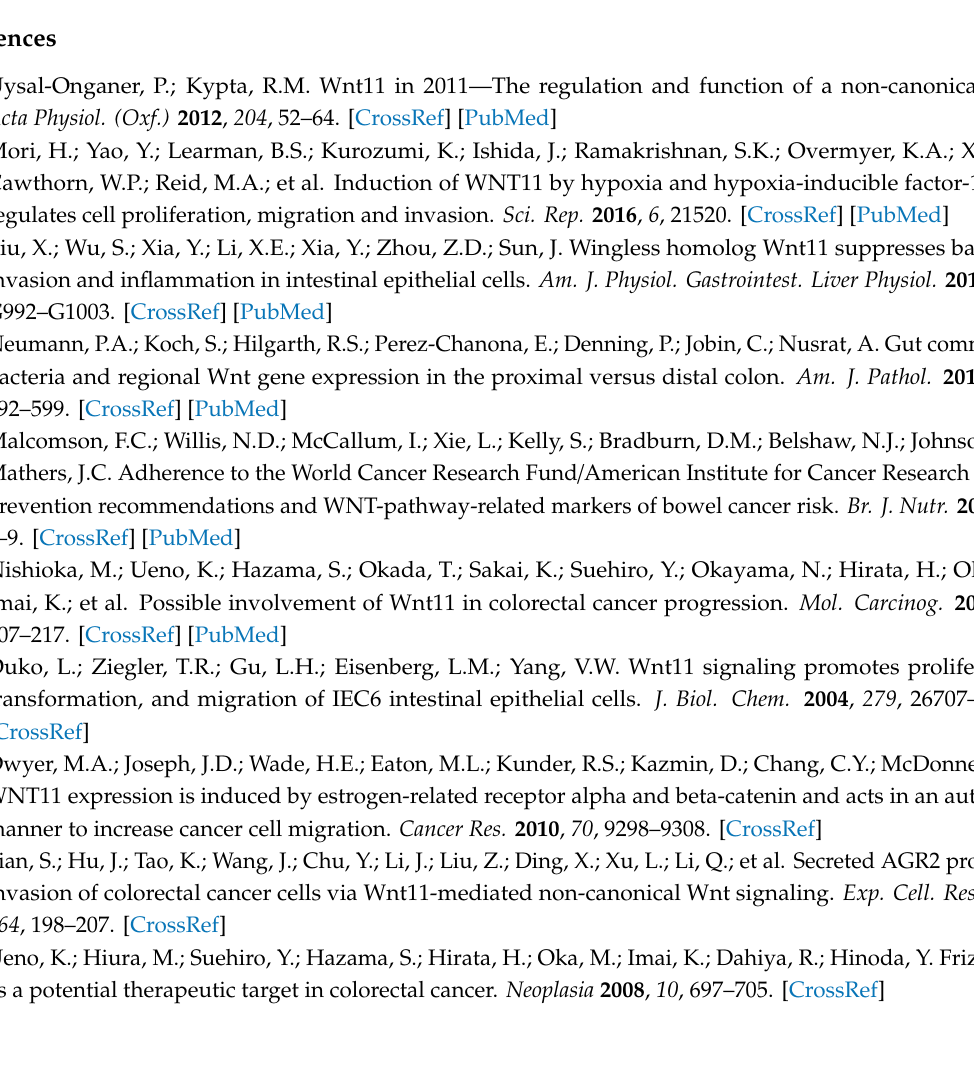
Wnt receptor expression in colorectal cancer, Table S2: Comparison of patients with tumors having very high Wnt-11 versus moderate, low or no Wnt-11 (Figure 2a), Table S3: Comparison of patients with tumors having high or very high Wnt-11 versus moderate, low or no Wnt-11, Table S4: Unadjusted analysis for 3-year mortality, Table S5: Unadjusted analysis for 5-year mortality, Table S6: Adjusted analysis for 3- and 5-year mortality, Table S7: Summary of results of the prediction of 3- and 5-year mortality, Table S8: Summary of results of the prediction 5-year mortality (Figure 3b), Table S9: Patient sociodemographic and clinical features according to Wnt-11 classification in Figure 3d, Table S10: Summary of results of the prediction 5-year mortality (Figure